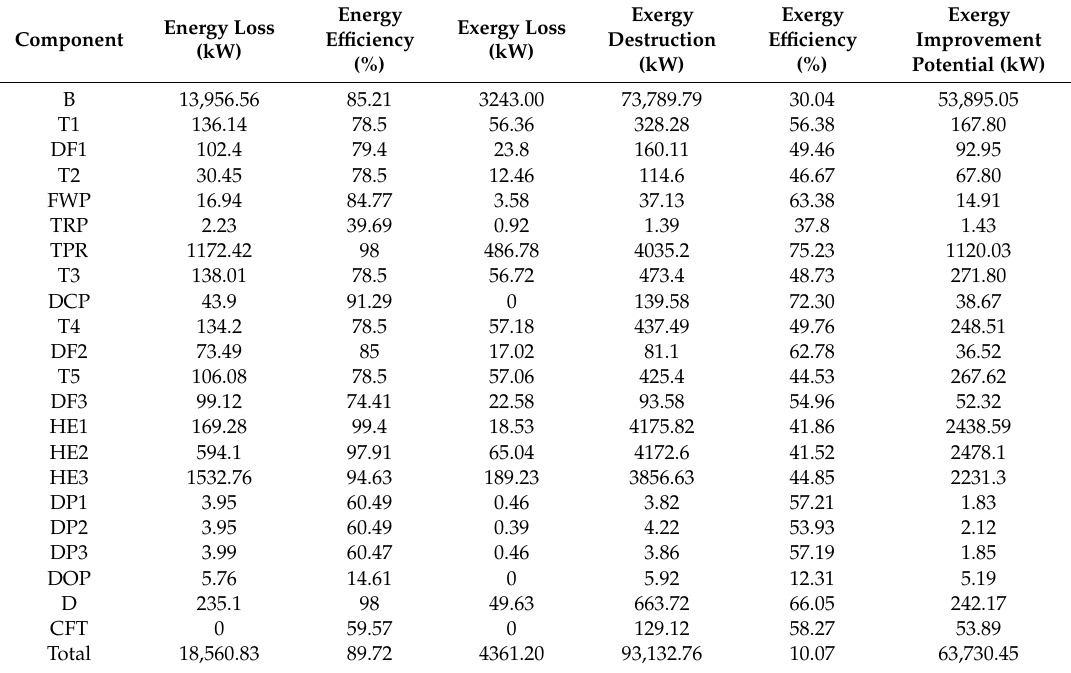
Table A4. The results of energy and exergy